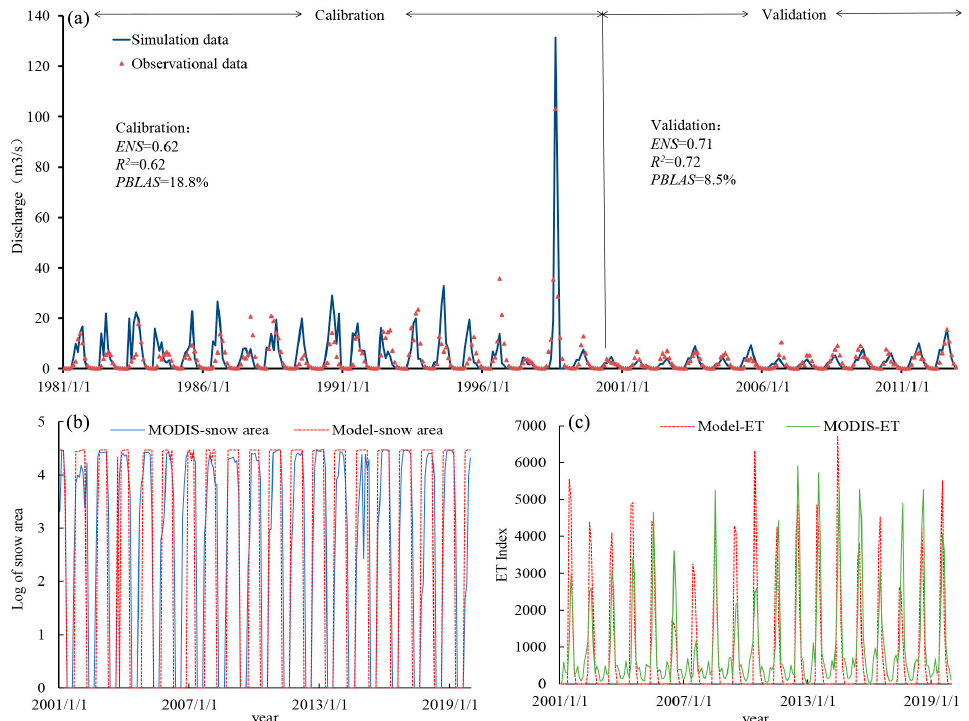
Figure 2. Comparison of SWAT model simulation results and measured discharged ( a ), MODIS snow cover ( b ), and evapotranspiration ( c ) in the URB.